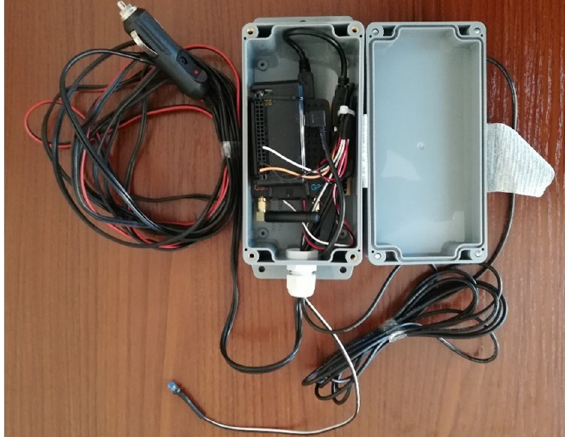
Figure 3: Renault Captur vehicle used for the tests. Figure 4: The interior of the measuring